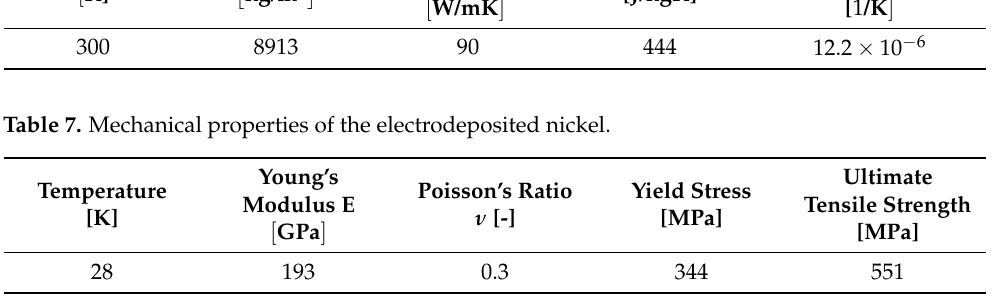
Figure 8. Convective boundary conditions.